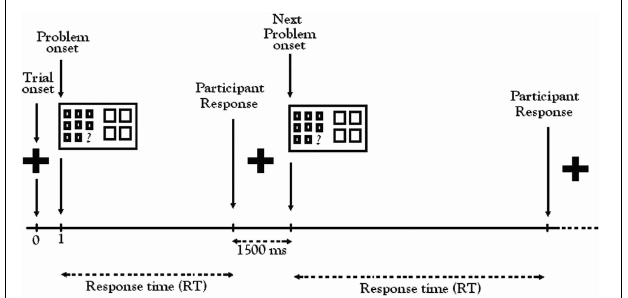
FIGURE 2 | Color relational complexity (CRC) fMRI task sequence. CRC task was a self-paced, event-related design with runs administered in counterbalanced order. Color, No-Color, and Black-white visual contrast matrix items were randomly distributed across three functional runs containing 13 trials of each condition at 0, 1, and 2 levels of